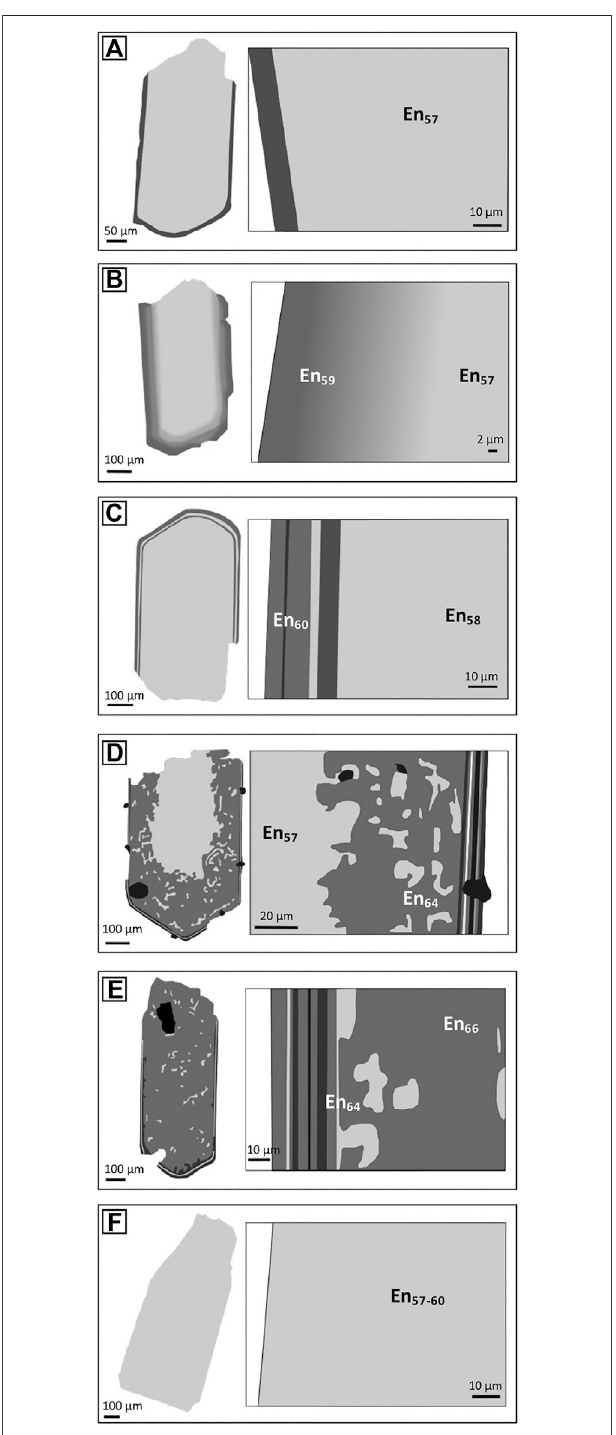
FIGURE 7 | Schematic representation of the fi ve different crystal types with zoning, along with high magni fi cation schematic of the crystal rims showing representative zoning for the crystal type. Enstatite compositions are shown for crystal rims and cores. (A) Type-1 crystals are simple and have a single sharp zone. (B) Type-2 crystals are also simple with single zone but the zones are diffuse and a sharp boundary is not observed. (C)